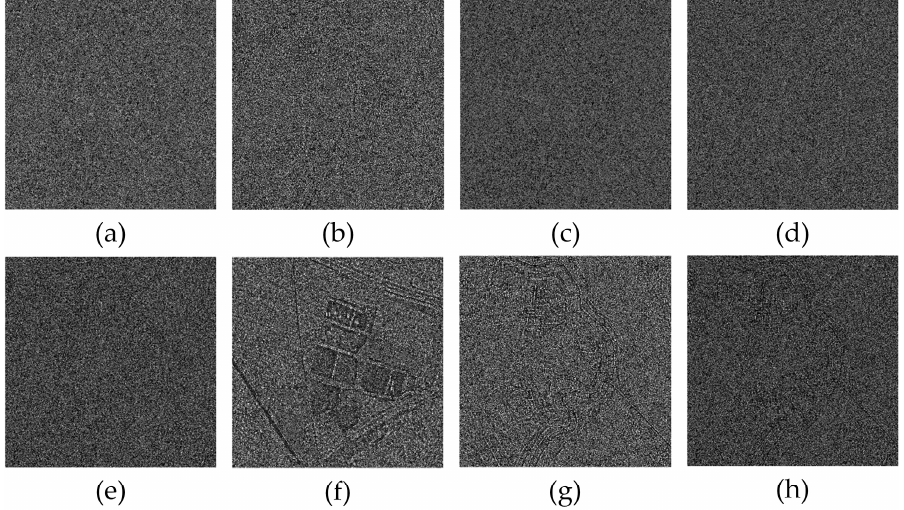
Figure 11. Ratio images between noisy and filtered TerraSAR-X SAR images using ( a ) DPAD, ( b ) EnLee, ( c ) SAR-BM3-D, ( d ) FANS, ( e ) PPB, ( f ) DnCNN, ( g ) NL-means, and ( h ) MDLPIA-NLM fil- ters.